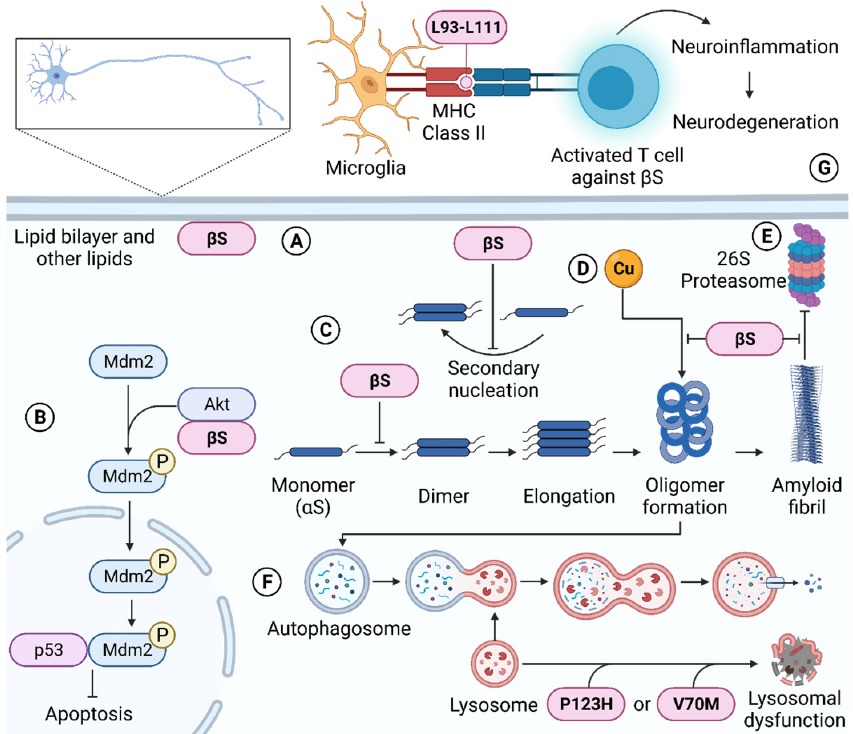
Figure 3. The diverse functions of β S. Inside the neuron, β S binds to lipids through its N-terminal region ( A ). β S also inhibits apoptosis ( B ), potentially via its direct interaction with Akt. Akt phos- phorylates Mdm2, which is then shuttled into the nucleus and binds to p53. β S also suppresses the early-stage aggregation of α S ( C ) by blocking the monomer to dimer transition and secondary nucle- ation of α S. β S sequesters copper and mitigates the formation of toxic copper-induced α S oligomers ( D ). Aggregated α S inhibits the 26S proteasome, but prior incubation with β S overrides this inhibition ( E ). α S oligomers are cleared by the autophagy-lysosomal pathway. P123H and V70M β S mutations have been linked to lysosomal dysfunction ( F ). Outside the neuron, T cells reactive against L93-L111 of β S are recognized by the MHC class II complex of antigen-presenting cells such as microglia in the brain. The activated T-cells promote neuroinflammation, resulting in neurodegeneration ( G ). This diagram was created with BioRender.com (license agreement number PT239C7U6L, access date 30 November